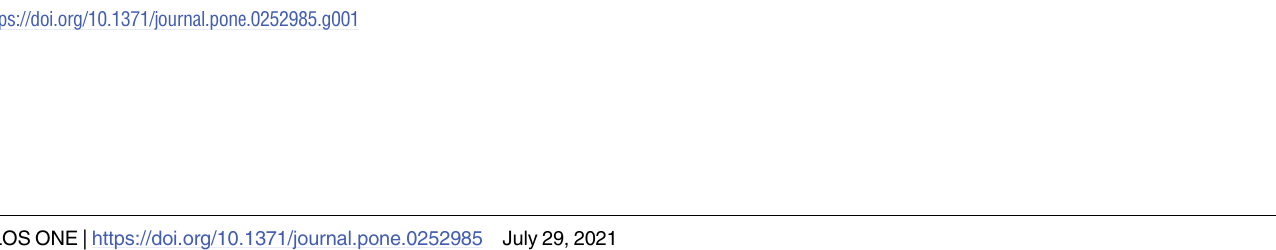
PLOS ONE | https://doi.org/10.1371/journal.pone.0252985 July 29,